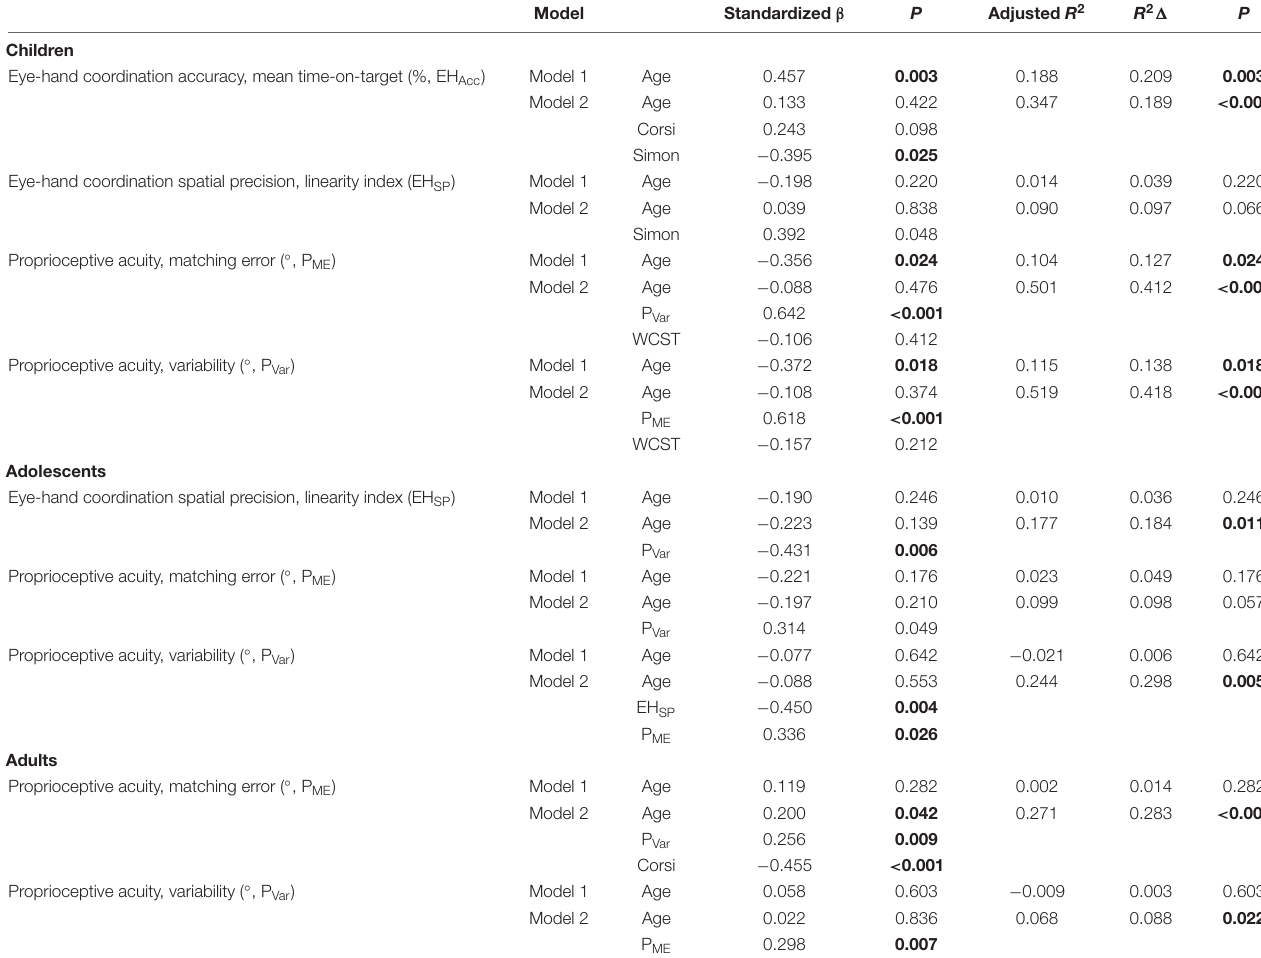
TABLE 5 | Hierarchical multiple regression